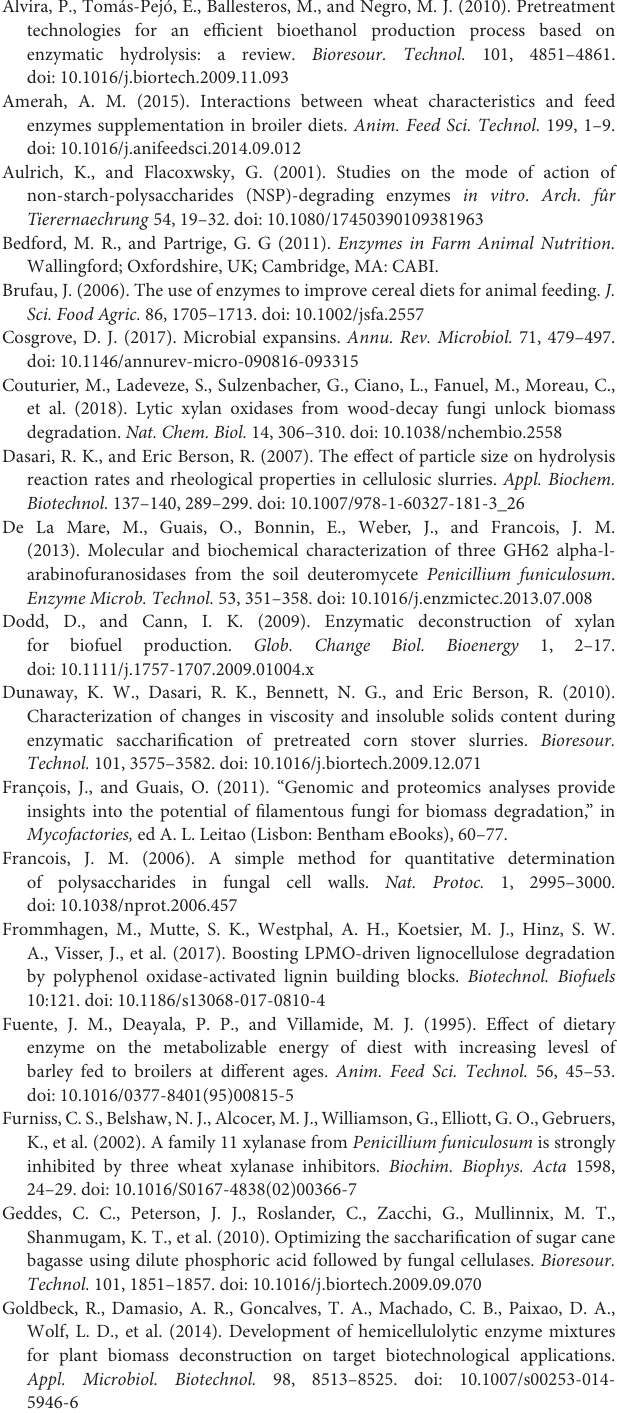
Table S2 | Sugars, proteins and total matter (%w/w initial dry matter) solubilized during enzymatic treatment of the destarched wheat bran by xylanase C (B). Operating conditions identical to Figure 2